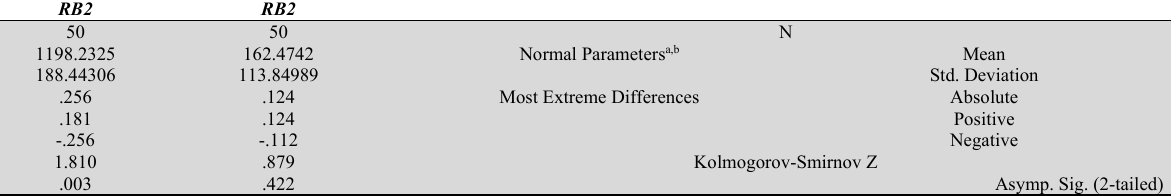
Result of Kolmogorov-Smirnov test for remain budget data of 2 states